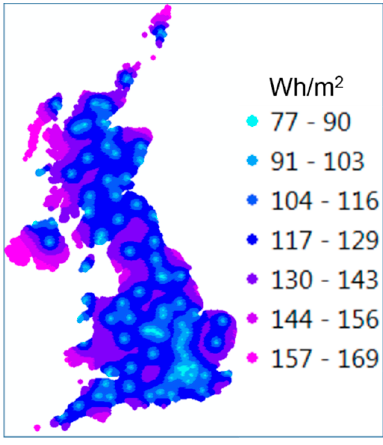
Figure A5. Kriging standard error (Wh/m 2 ) 11:00 a.m. on 1 June 2012.